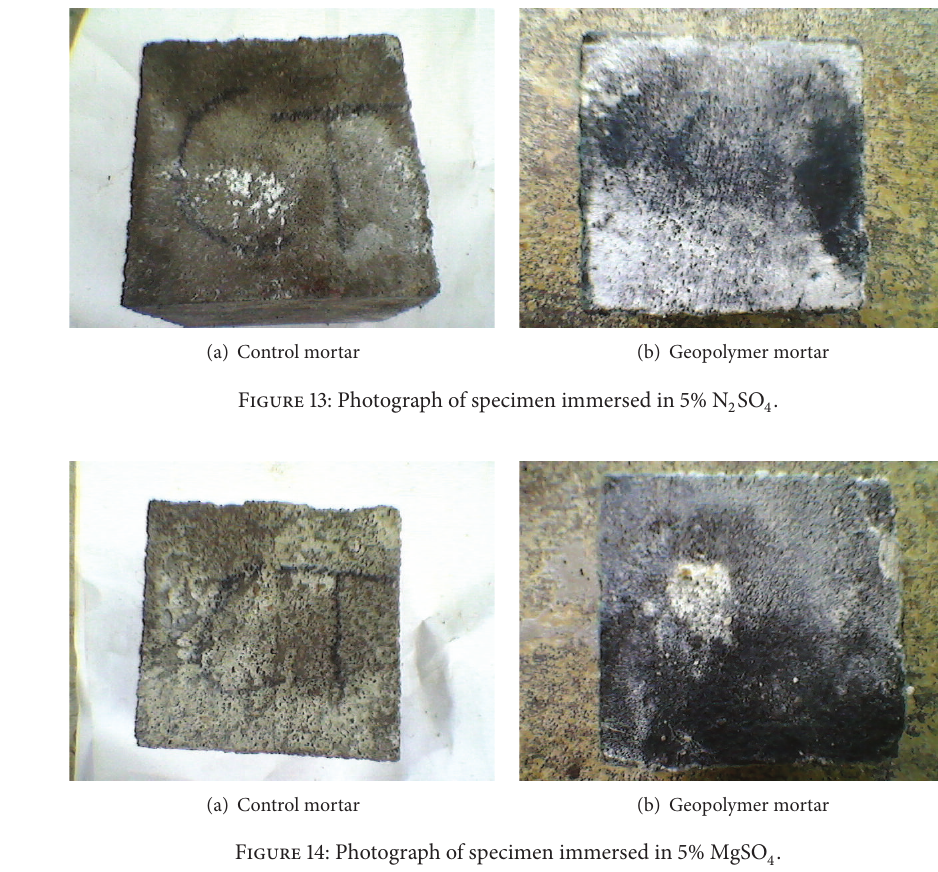
Figure 14: Photograph of specimen immersed in 5% MgSO 4 .